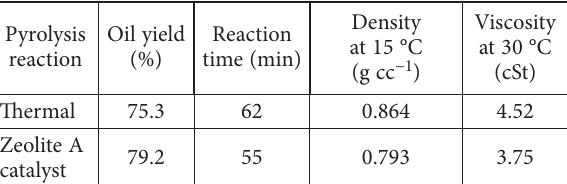
Figure 6. Comparison of reaction rate in thermal and catalytic reaction Table 2. Pyrolysis experimental results at 500